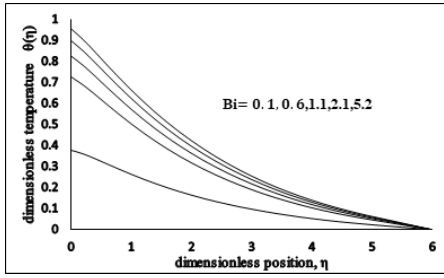
Figure 11. T Dimensionless Temperature vs Bi .